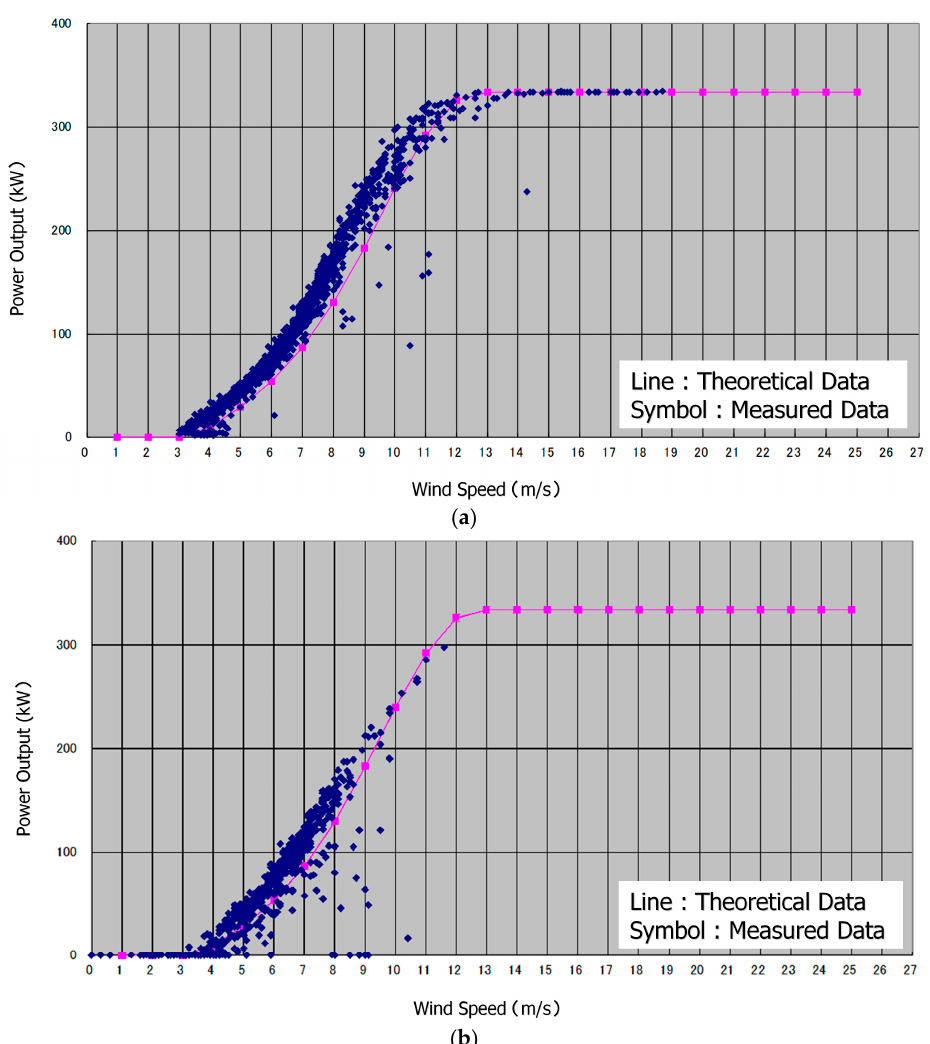
Figure 7. Comparison between theoretical data and measured data for wind turbine #10. ( a ) Northerly wind. ( b ) Easterly wind.